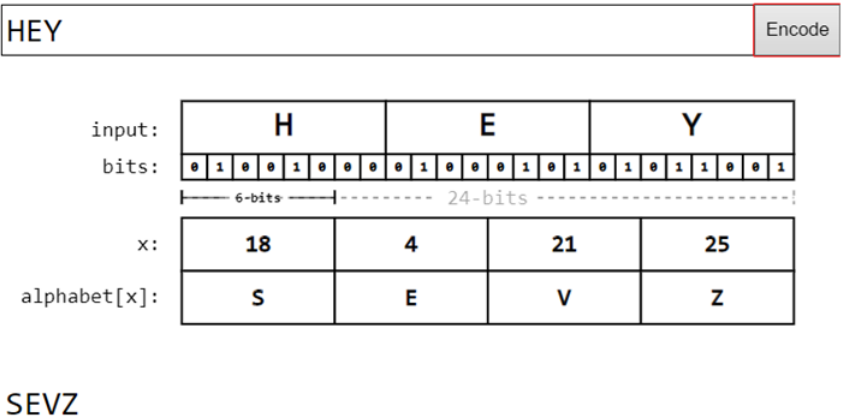
Figure 19. Compression